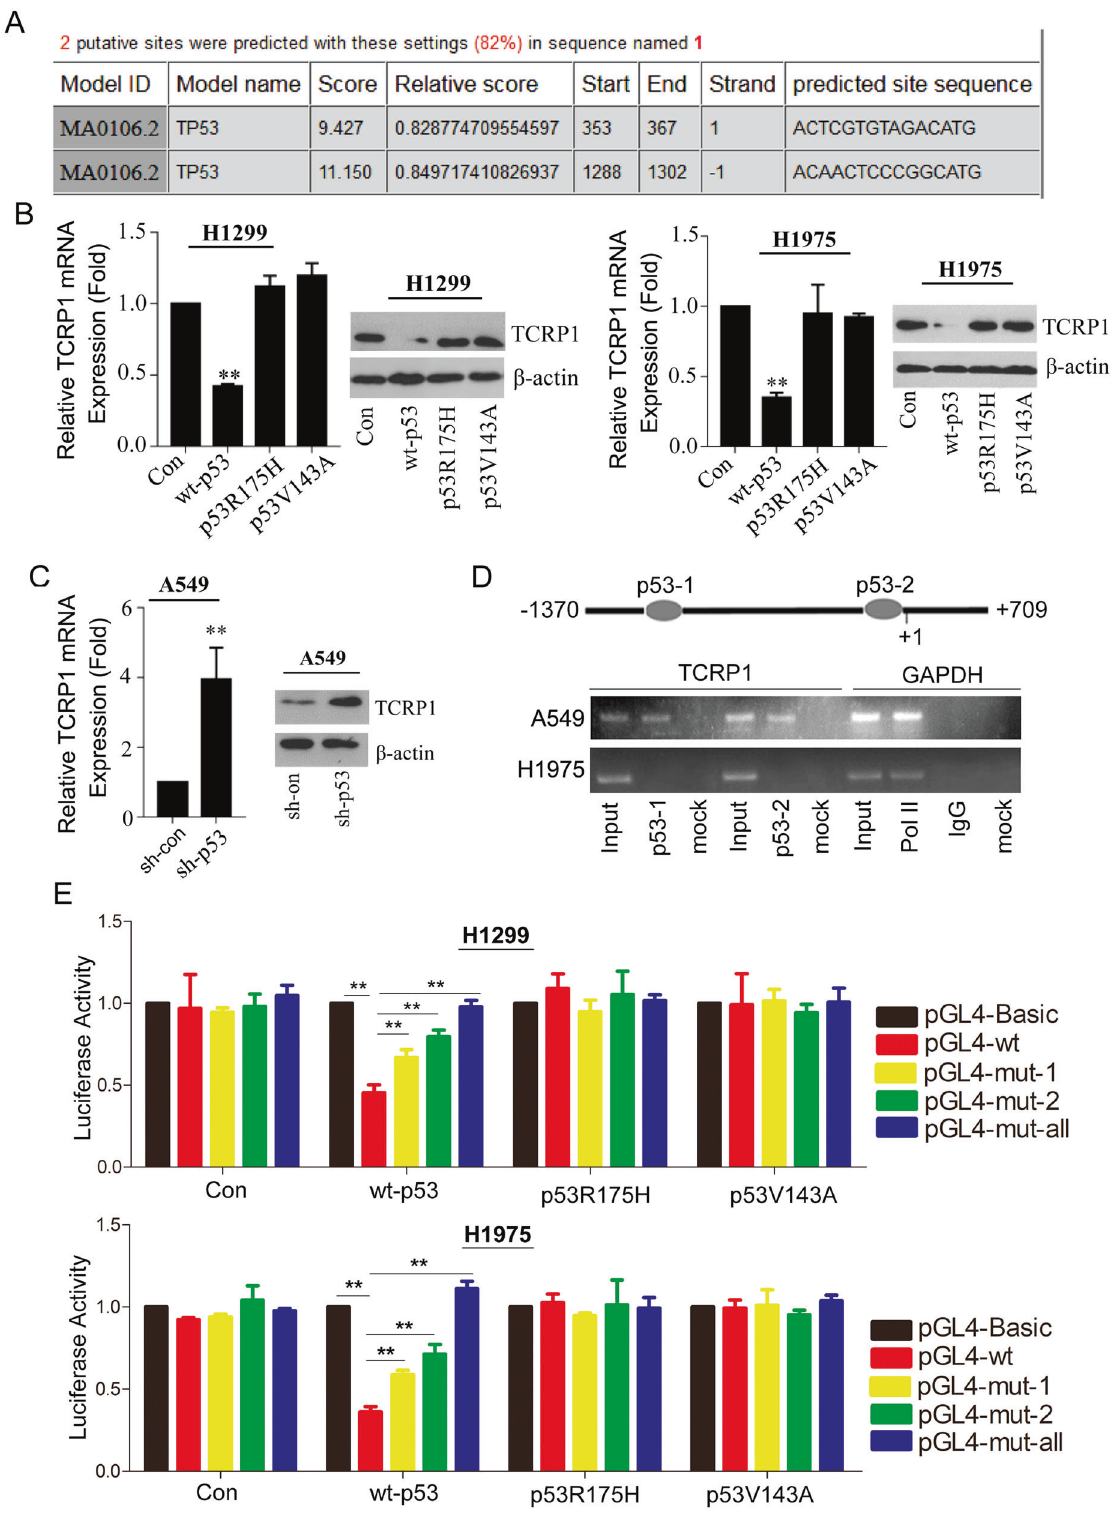
induce the expression of several critical genes involved cancer initiation and progression. To determine whether mutant p53 modulated the expression of TCRP1, we generated stable cells to restore p53 mutants (R175H, V143A) in p53-deletion H1299 cells (Fig. S1A). The results demonstrated that overexpression of